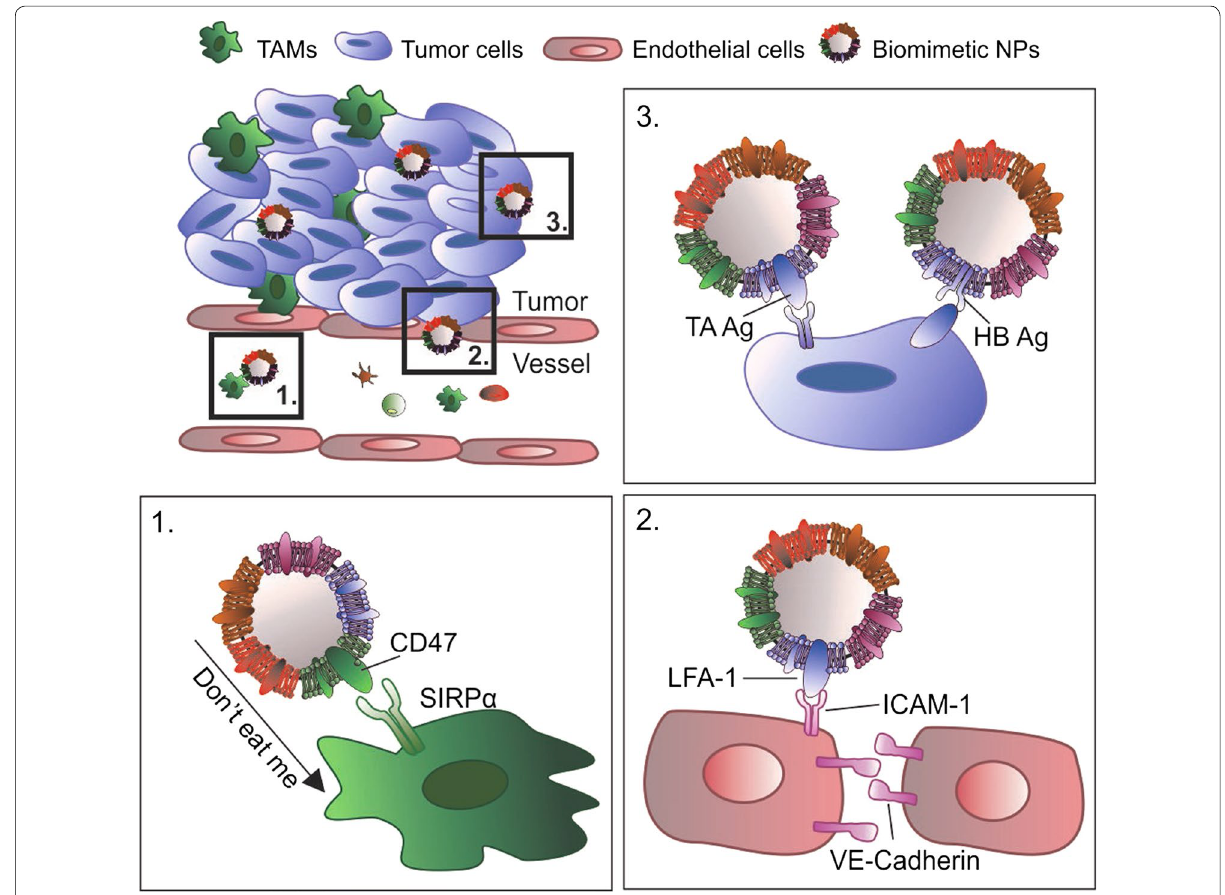
Fig. 2 Biomimetic nanoparticles (NPs) inherited specific properties from the donor cell source, such as: 1. ability to escape mononuclear phagocyte system (MPS) resulting from the expression of the “do not eat me” cell signal, CD47, and its interaction with its receptor signal-regulatory protein alpha (SIRPα) on the macrophage surface; 2. adhesion to inflamed endothelium and activation of the Lymphocyte function-associated antigen 1/Intracellular adhesion molecule-1 (LFA-1/ICAM-1) pathway that alters tight junctions between endothelial cells, resulting in increased vessel permeability; 3. tumor targeting potential via expression of tumor associated (TA) and homotypic binding (HB) antigens (Ag) recognized by tumor cells. TAMs Tumor associated